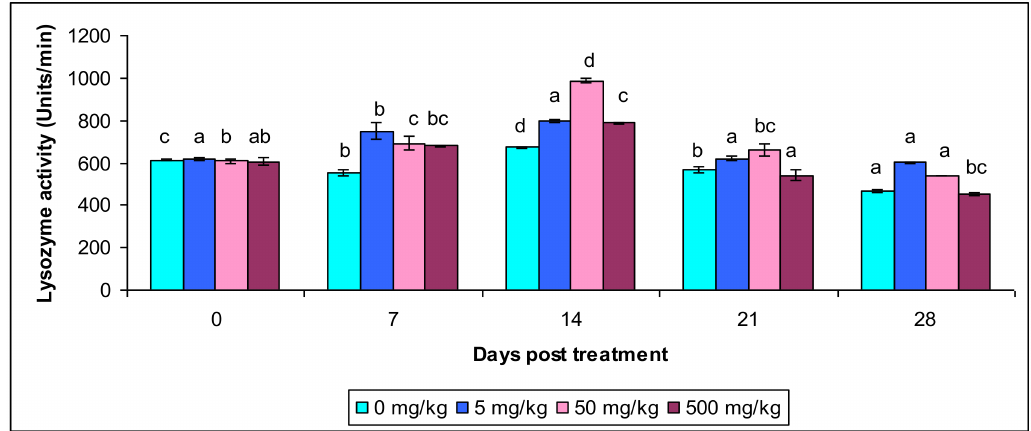
Figure 2. Serum lysozyme activity under different treatments administered with various levels of C. aerea extract in L. rohita during post treatment days (values are mean ± SE). Mean values with different superscript within a column for a parameter is significantly different ( p <